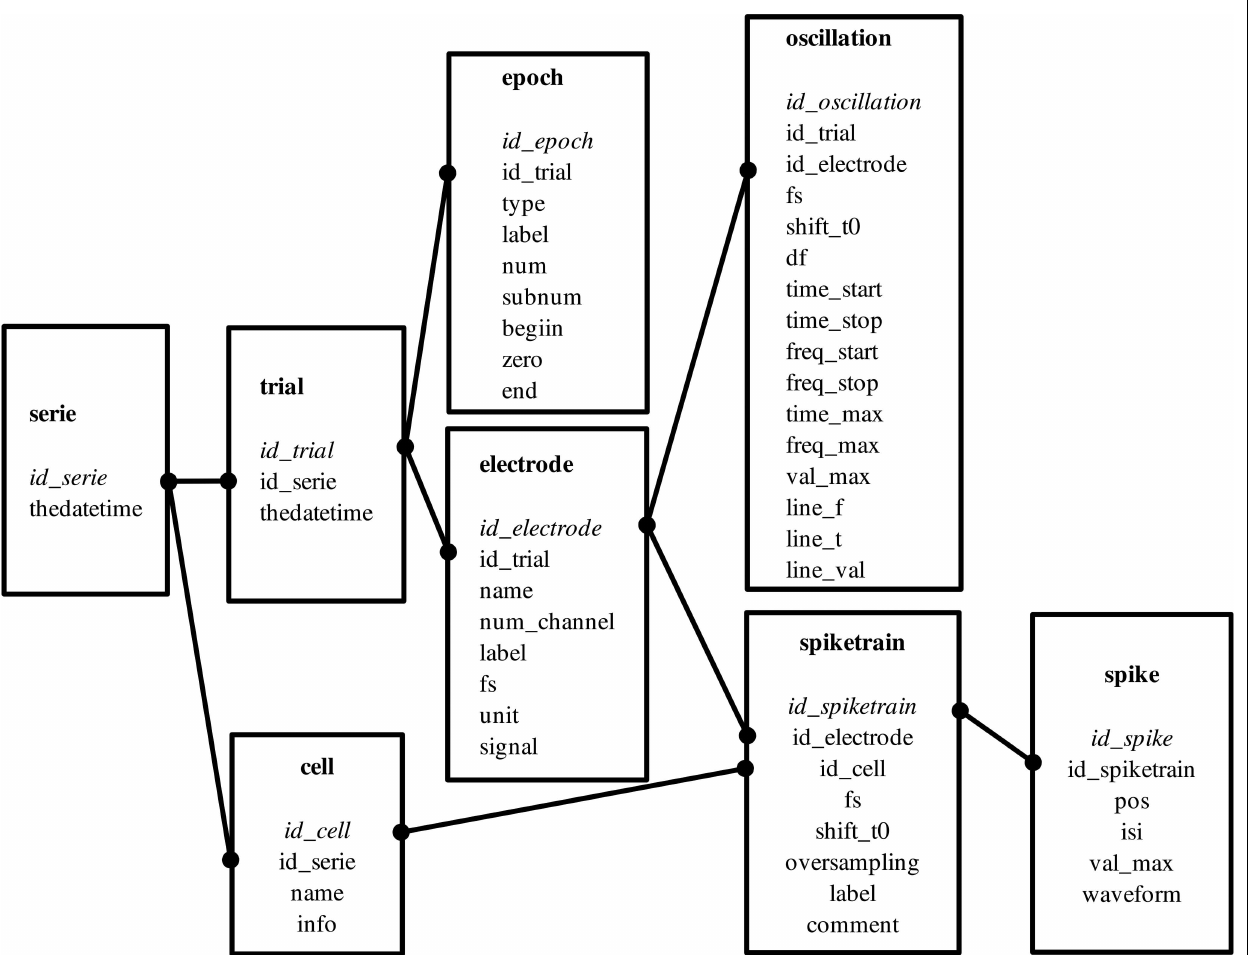
and are stored in the electrode or epoch tables, respectively. Additional tables are as follows. The series table, which gathers a set of trials (e.g., those recorded in the same location). The spike table contains all detected spikes and their positions and shapes. The spikes are grouped according to their spike train (there may be many spike trains per electrode). The cell table groups spike trains that were recorded from the same cell but in different trials; thus, the cell table groups them relationally. Finally, the oscillation table contains all of the information related to transient oscillatory events (see Section “Oscillation